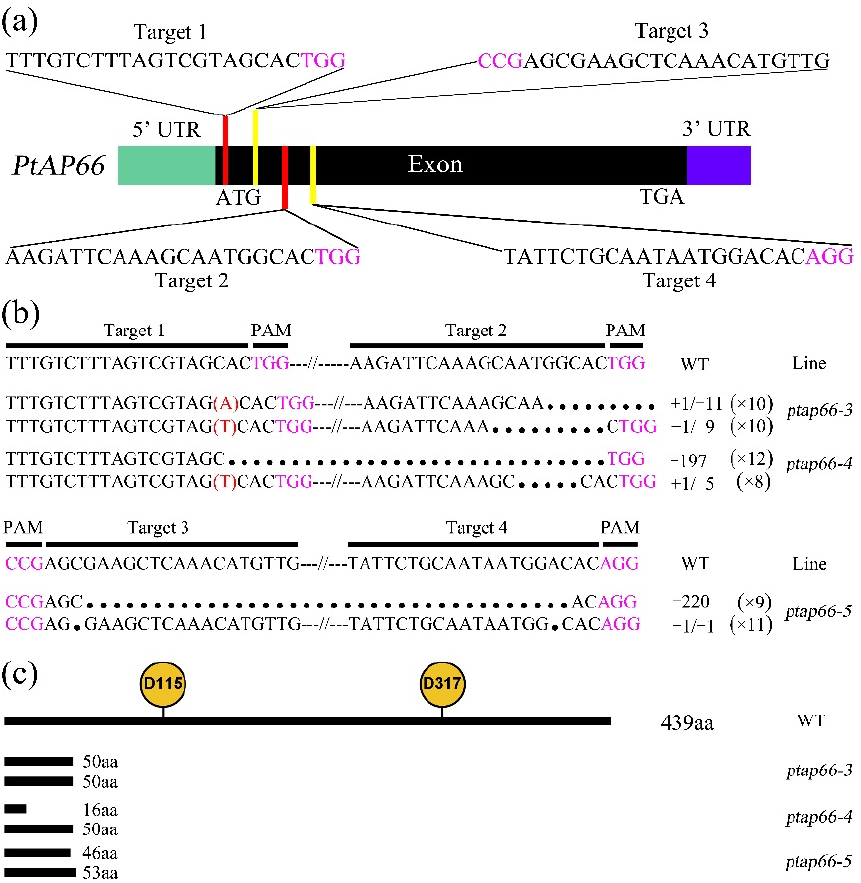
Figure 3. CRISPR/Cas9-induced PtAP66 mutations in P. trichocarpa . ( a ) Diagram of two pairs of CRISPR/Cas9 target sites of PtAP66 . The exon is displayed as a black box, while untranslated regions (UTRs) are displayed as coloured boxes. Target1/2 and Target3/4 indicate the positions of gRNA-targeted sites by different pHSE401-2gRNA vectors. ( b ) Mutations at the gRNA target site for PtAP66 mutants. Black text denotes the native gRNA target sequences, purple text denotes the PAM (protospacer adjacent motif); dots indicate the deleted nucleotides; and red letters in parentheses represent the inserted nucleotides. The text on the right summarises the mutation details in three independent CRISPR/Cas9-induced lines. ( c ) Schematic representation of selective mutated PtAP66 proteins. The native protein is composed of 439 amino acids, and the highly conserved aspartic residues (D115/317) are indicated by the yellow circle. The amino acid numbers deduced by Cas9/gRNA induction are indicated to the right.